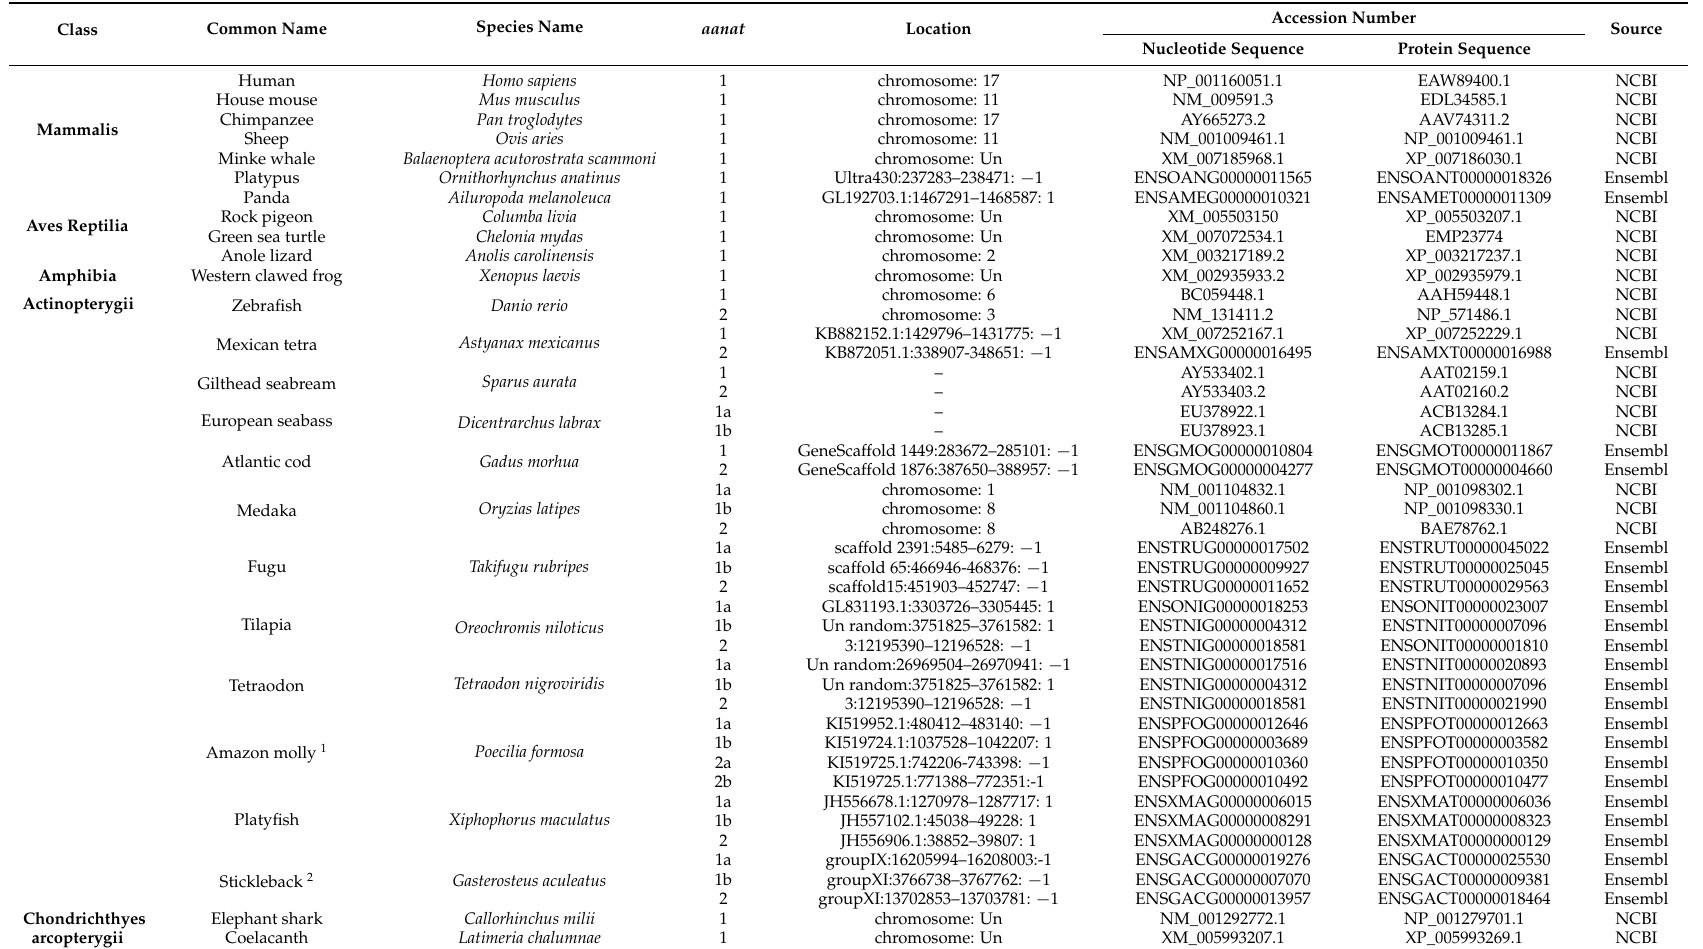
Table 1. The accession numbers for known aanat